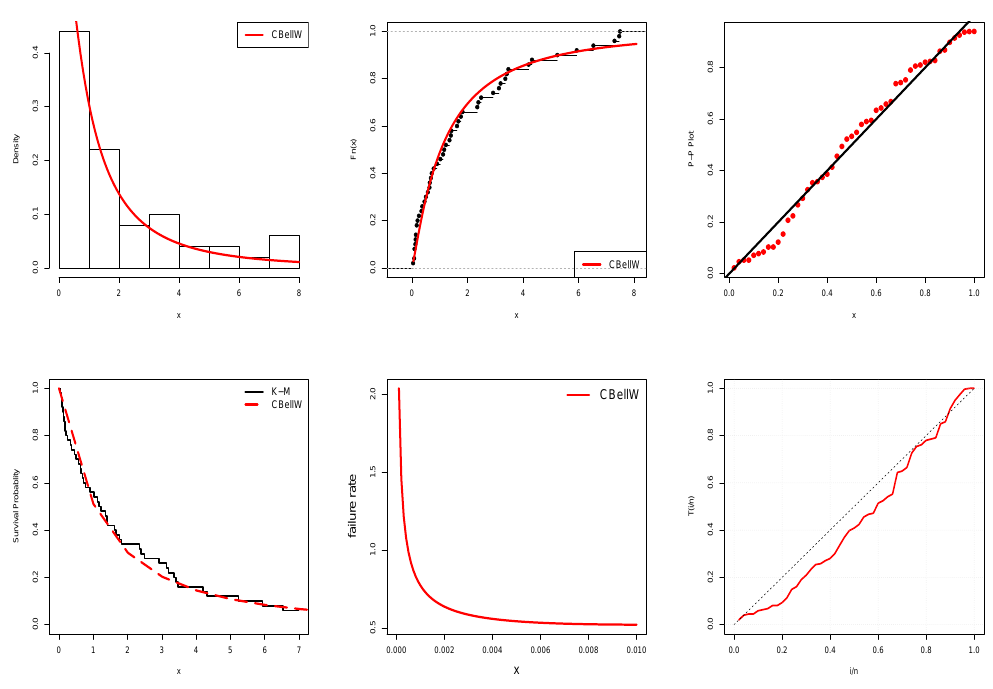
Figure 3. Graphical illustration of estimated plots under CBellW model of